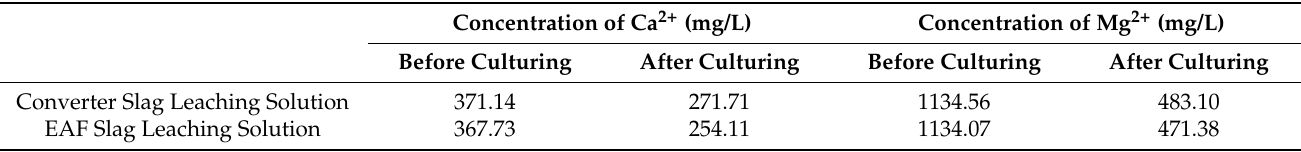
Table 7. Concentrations of Ca 2+ and Mg 2+ in F/2 medium containing steel slag leaching solution before and after culturing Nannochloropsis sp. Concentration of Ca 2+ (mg/L) Concentration of Mg 2+ (mg/L) Before Culturing After Culturing Before Culturing After Culturing Converter Slag Leaching Solution 371.14 EAF Slag Leaching